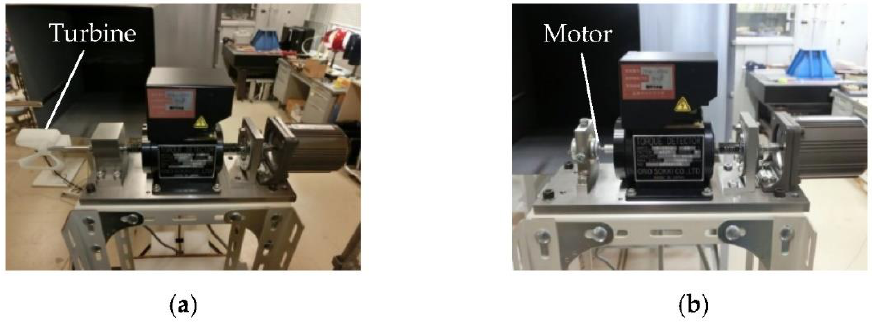
LGU35-4SRS: Yao, Japan; acceleration ratio of 3.66) as illustrated in Figure A2a. The rotational speed of the induction motor was controlled with an inverter. Wind speed was measured by a Pitot tube placed in a uniform flow generated by a wind tunnel (cross sectional area of the nozzle exit: 300 mm × 300 mm). The distance between the wind turbine and the wind tunnel exit was 300 mm. In the torque measurement of a direct current motor with no current (no-load condition) in Figure A1b, the motor supported by a motor holder was directly connected to the torque detector as illustrated in Figure A2b.